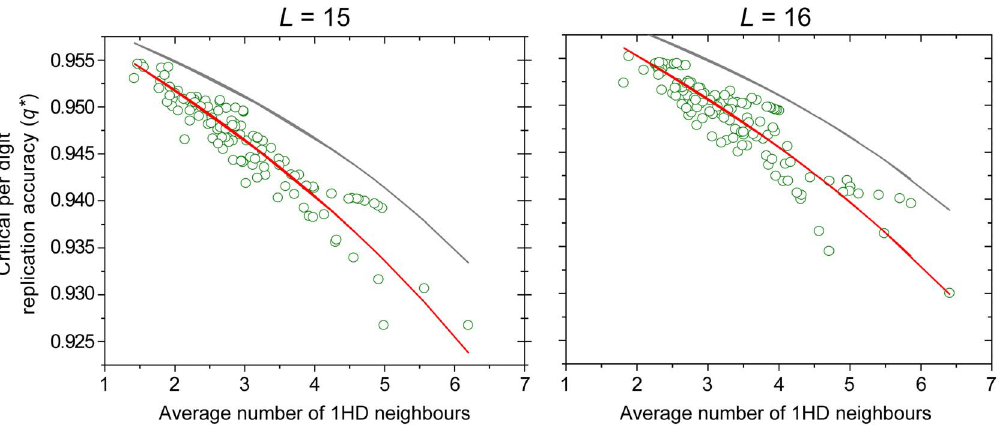
Figure 3. Correlation of the error threshold with average number of 1–Hamming distance neighbours. Critical per digit replication accuracy of SSCs as a function of the average number of 1–Hamming distance neighbours for sequences in the SSC. Red curves show fit of Eq. 3 to the data points, while the dark gray curve show fit to Eq. 3 with no back-mutations ( a ~ 0 ). Results are for L ~ 15 (left) and L ~ 16 (right). The average number of 1HD neighbours can be transformed to l by dividing it by the length of the sequence.